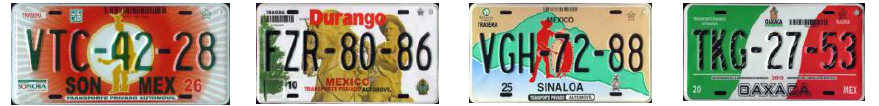
Figure 10. Failed segmentation samples of license plate images.